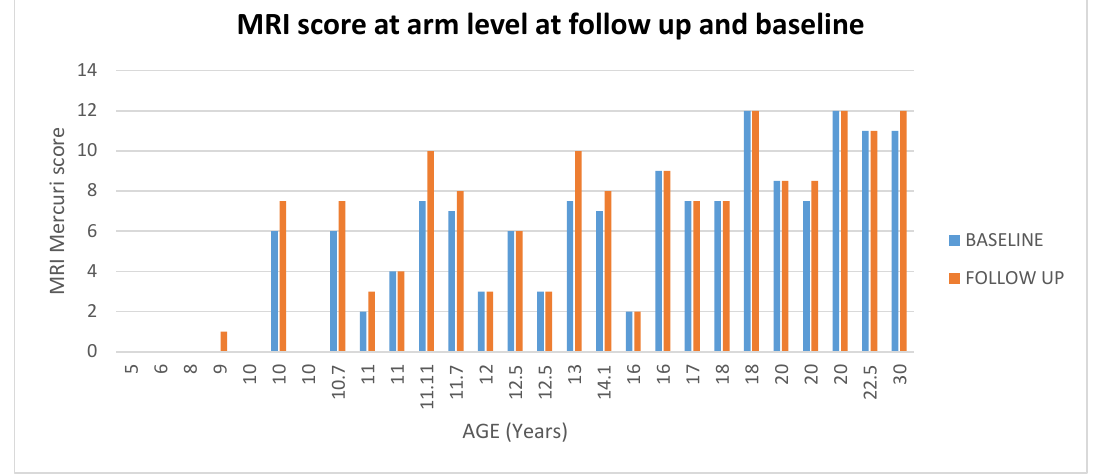
Figure 8. Detail of MRI and PUL at arm level. Individual details of imaging and PUL findings at arm level. The shading reflects the severity of involvement with the score of 0 shown as a white cell, score of 1 as pale green, score of 2 as yellow, score of 3 as orange and score of 4 as red. The grade 2.5 was used to identify patients with 2b involvement. Bic = biceps brachii; brac = brachialis;tri = triceps brachii; A= ambulant; EA = early ambulant; NA= non ambulant; ENA = early non ambulant; LNA: late non ambulant. ● Black circle means a higher Mercuri score respect to the baseline in the respective muscle. Blue line indicates changes in both MRI and PUL scores.